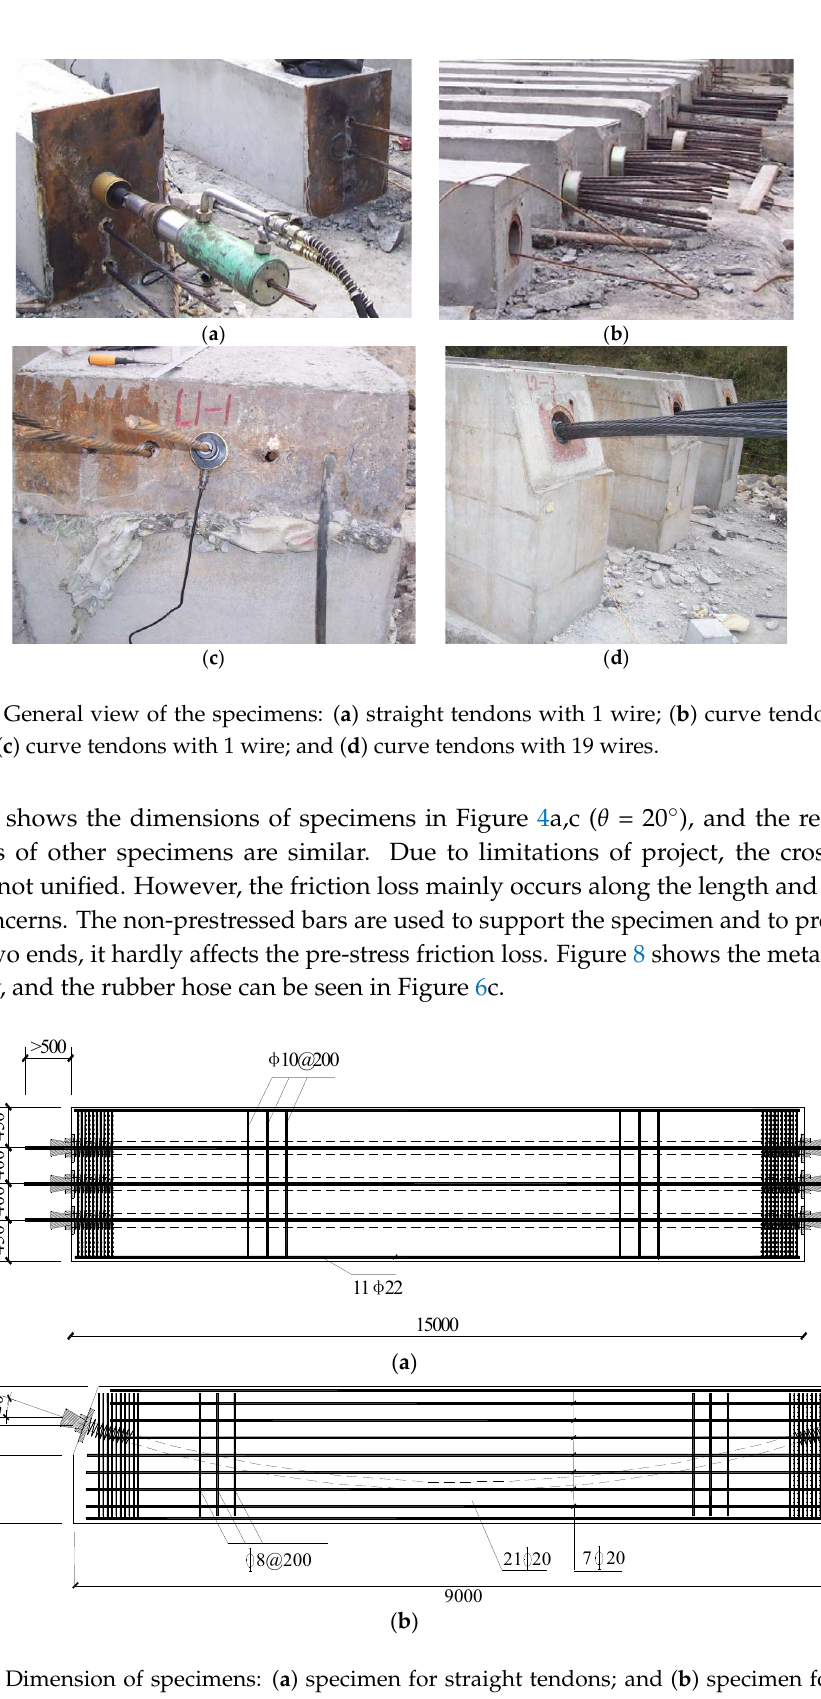
Figure 7. Dimension of specimens: ( a ) specimen for straight tendons; and ( b ) specimen for curve tendons (unit: mm).